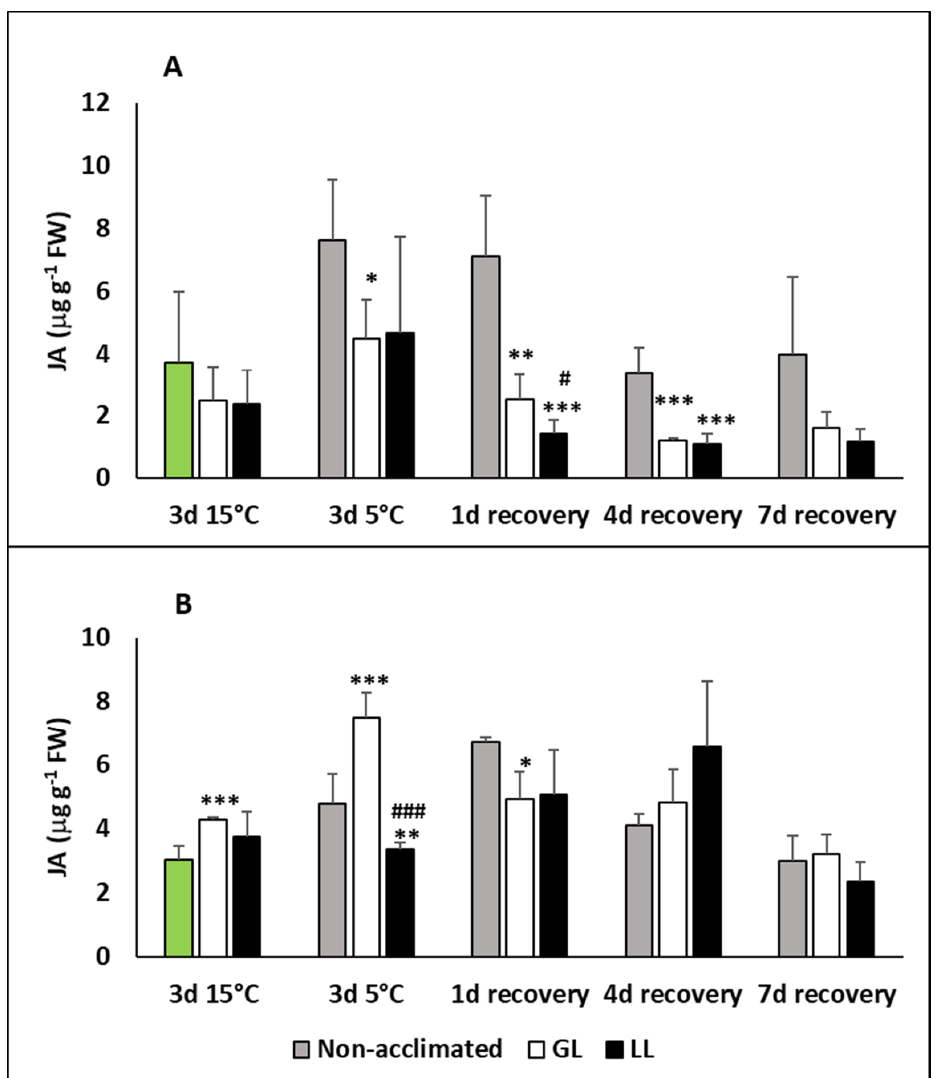
Figure 4. Changes in the jasmonic acid (JA) contents during cold acclimation (15/13 °C), chilling (5 °C) and recovery in the leaves and roots of young maize plans: control plants (22/20 °C, 387 µmol m −2 s −1 ). Light intensities during hardening: GL: 387 µmol m −2 s −1 ; LL: 107 µmol m −2 s −1 . *, **, *** significant differences compared to the control plants on the same day at the p < 0.05, 0.01 and 0.001 levels, respectively. # , ### significant differences compared to the GL plants on the same day at the p < 0.05 and 0.001 levels, respectively. ( A : free JA in the leaves; B : free JA in the roots).